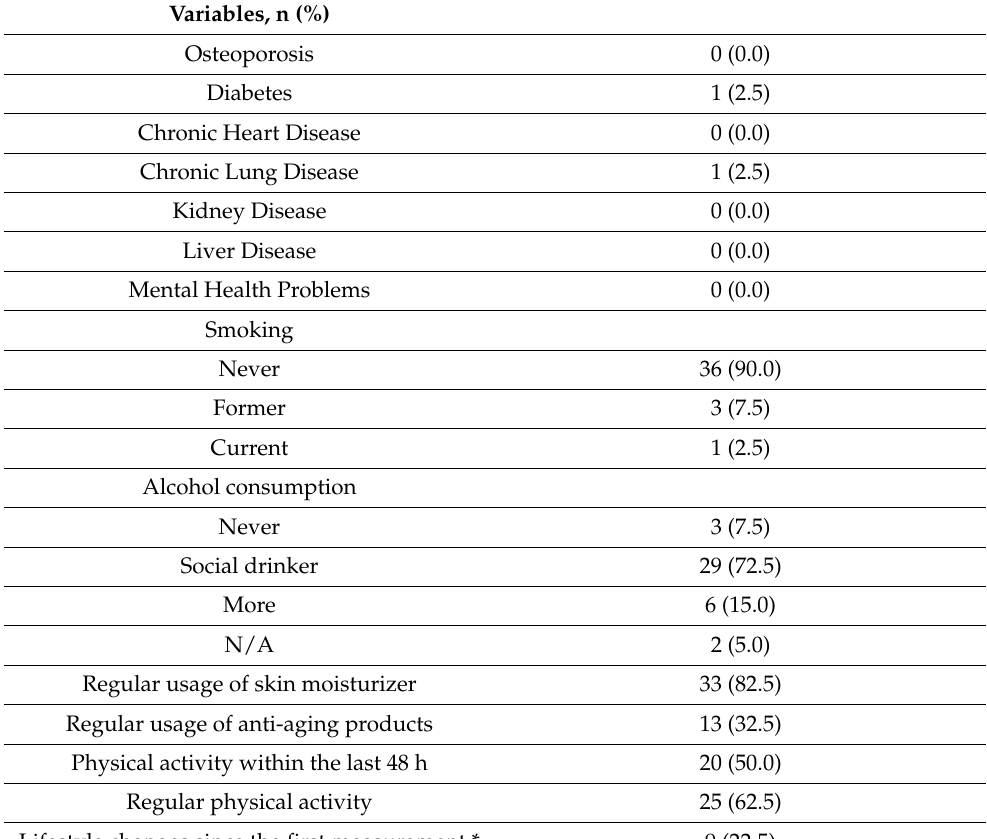
Table 2. Lifestyle and health status of study participants (n = 40). * This question was only used at timepoint